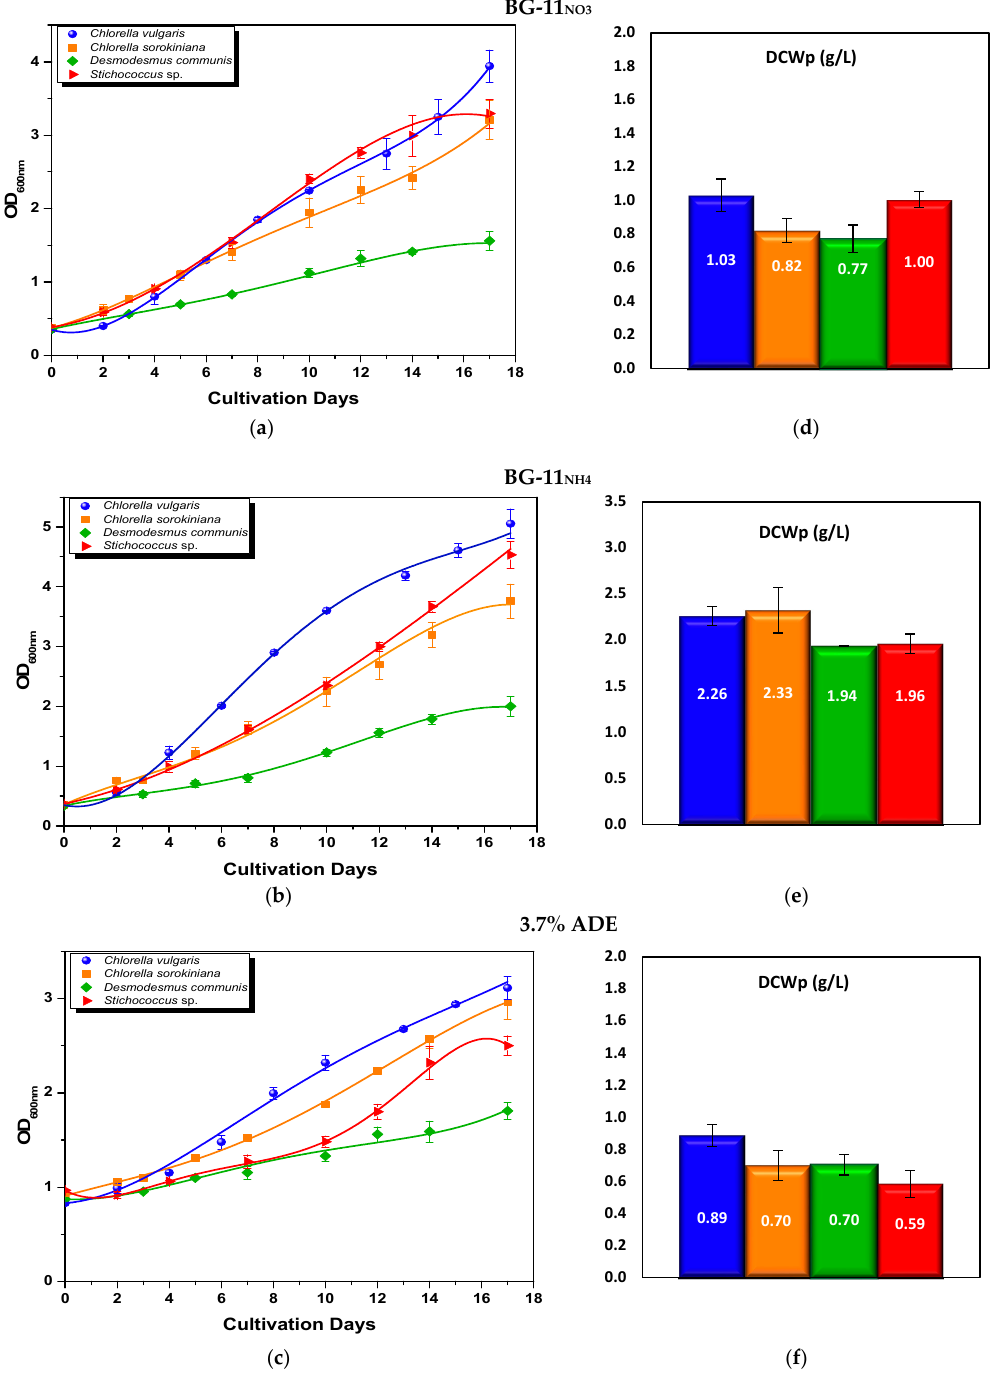
Figure 2. Optical density (OD 600nm ) ( a – c ) and biomass concentration values (DCWp) at the end of the culture period ( d – f ) of the four microalgae species in the three different media: blue bar: C. vulgaris , orange bar: C. sorokiniana , green bar: D. communis and red bar: Stichococcus sp. Specifically, Chlorella sorokiniana exhibited the maximum biomass production (DCWp), when cultivated in BG-11 NH4 (2.33 g/L), followed by Chlorella vulgaris (2.26 g/L), Stichococcus sp. (1.96 g/L) and Desmodesmus communis (1.94 g/L) (Figure 2e and Table S1). However, a similar behavior is not depicted in the respective optical density trajectories (Figure 2b), as C. vulgaris has the maximum OD 600nm at the end of the cultivation period followed by Stichococcus sp., Chlorella sorokiniana and Desmodesmus communis . The inconsistency between these values is explained by taking into consideration the concentration of pigments in each species (Figure 3 and Table S1). More specifically, C. vulgaris has the maximum chlorophyll a concentration (42.93 mg/L), compared to other 3 species, when BG-11 NH4 was used as cultivation medium, while extremely poor concentration of chlorophyll a measured in D. communis cultures (1.81 mg/) justifying the low OD values of this species, although its biomass concentration is comparable with Stichococcus sp. When nitrate was provided as nitrogen source (BG-11 NO3 ), lower DCW and OD values were recorded for all studied species. However, the observed comparative performance of each species changed when ammonium nitrogen was used. The cultures of C. vulgaris and Stichococcus sp. in BG-11 NO3 achieved the highest biomass